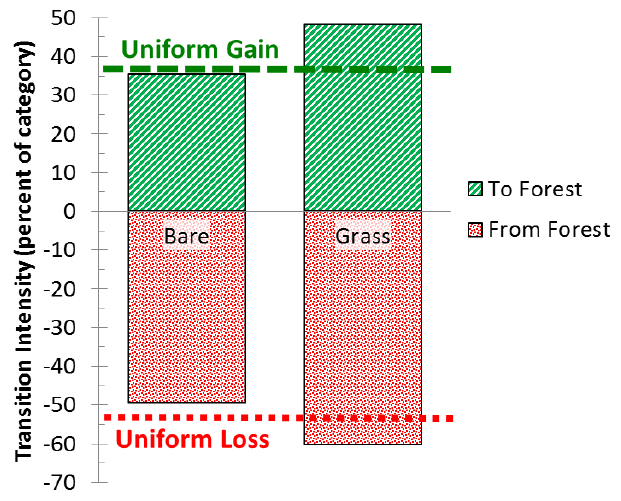
Figure 5. Intensity of transitions given Forest’s gain on the positive axis and given Forest’s loss on the negative axis.